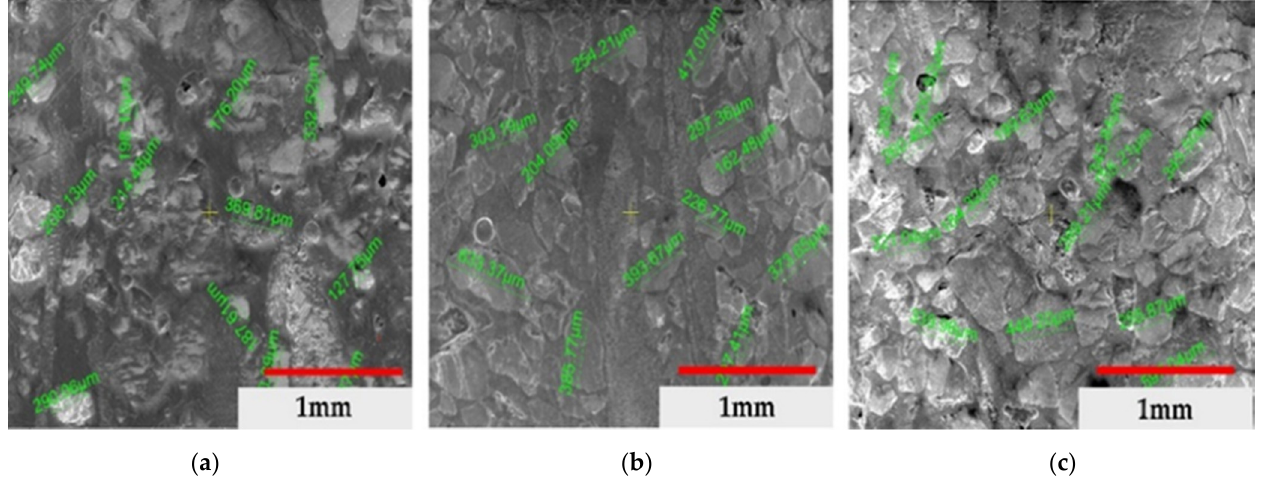
Figure 4. Average values of the particles: ( a ) neutral soil, ( b ) basic soil, ( c ) acidic soil.